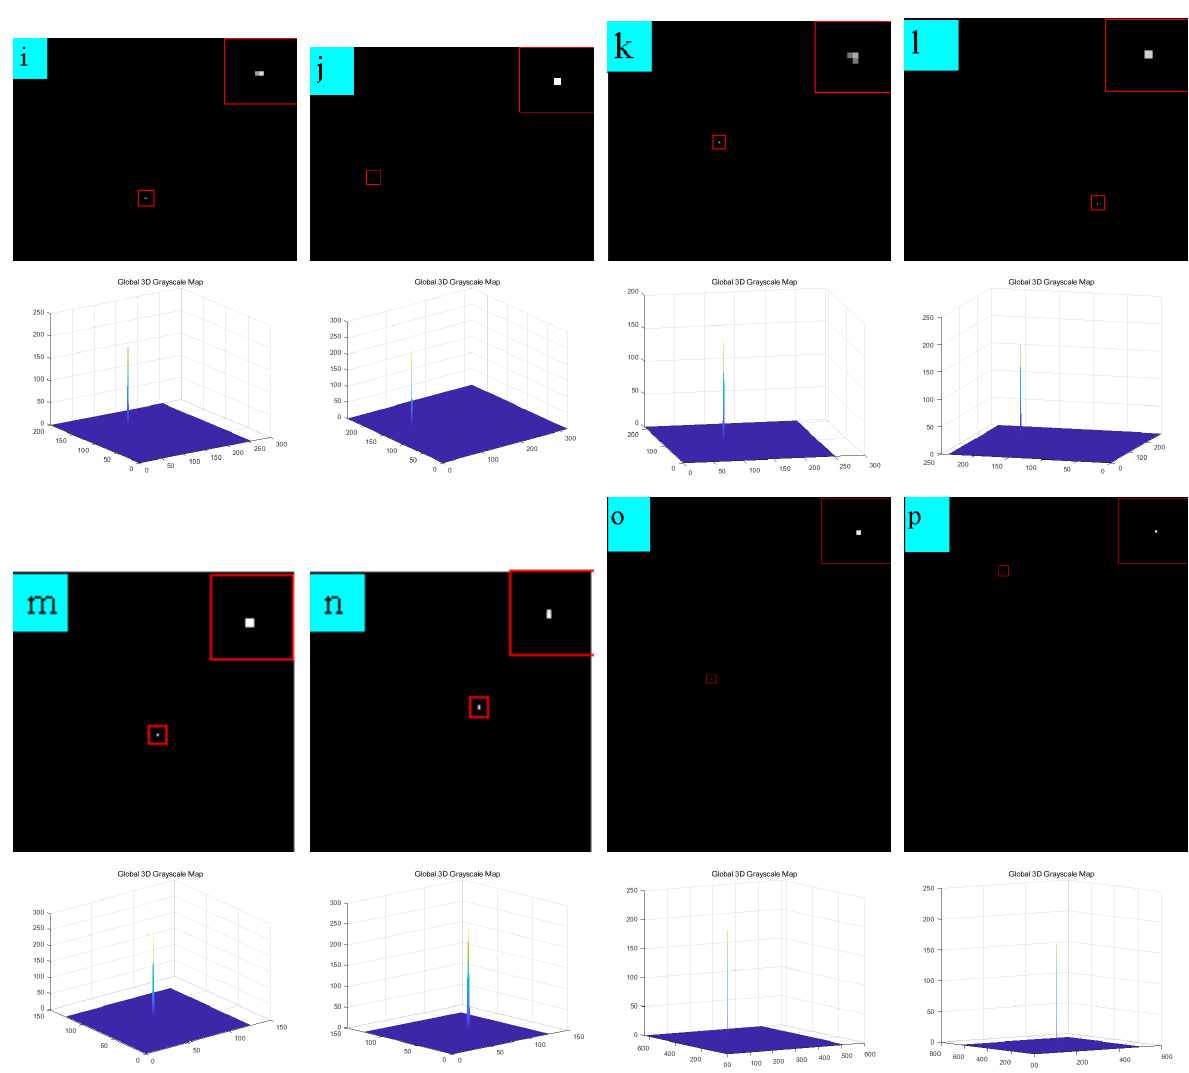
Figure 7. Detection results of the algorithm in this paper under 16 scenes. ( a – p ) are the detection results in 16 scenes, and the following is the three-dimensional map of the detection